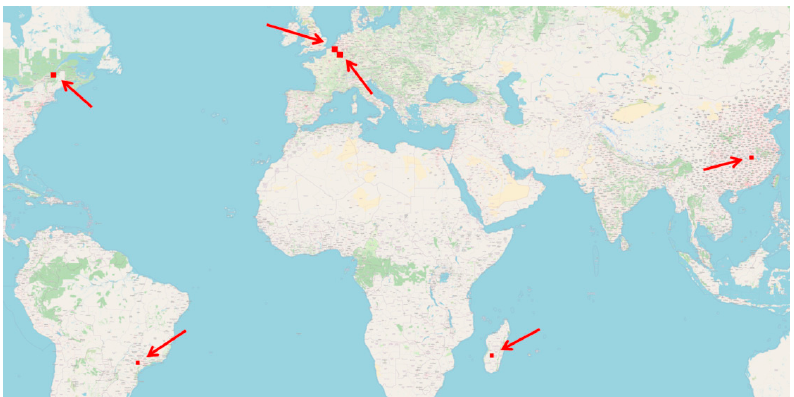
Figure 2. Location of the six selected Sentinel ‐ 2 tiles (Table 1). Background: OpenStreetMap. Remote Sens. 2020 , 12 , x FOR PEER REVIEW Table 1. Description of the six selected Sentinel ‐ 2 (S2) tiles (Figure 2). PS, PlanetScope.